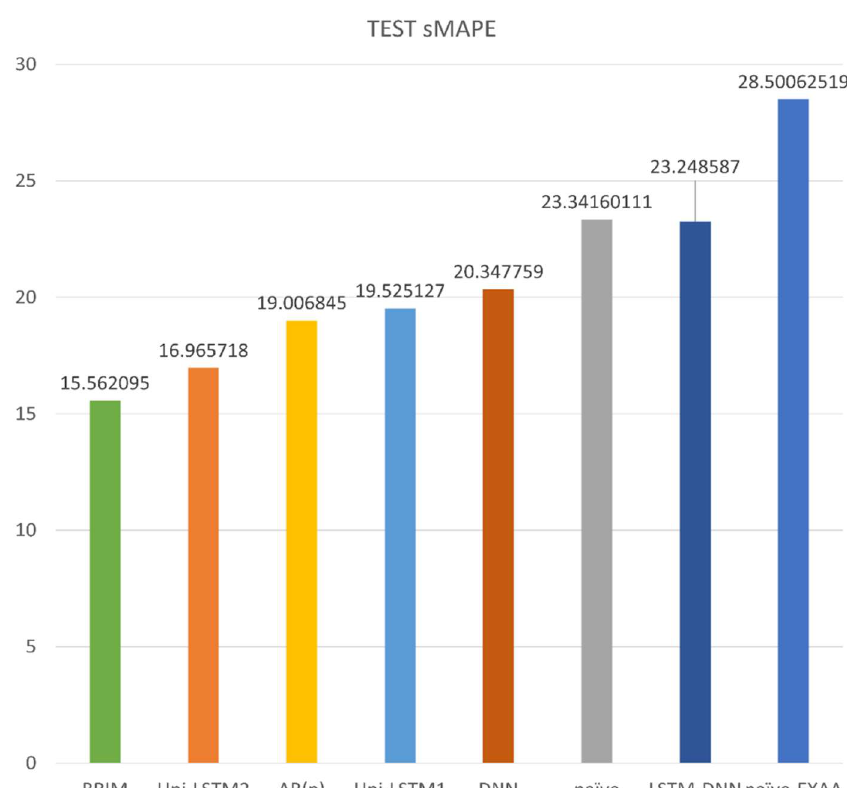
Figure 5. Comparison of the predictive performance of BRIM with benchmark schemes in the European Power Exchange (EPEX)-FR by means of symmetric mean absolute percentage error (sMAPE).